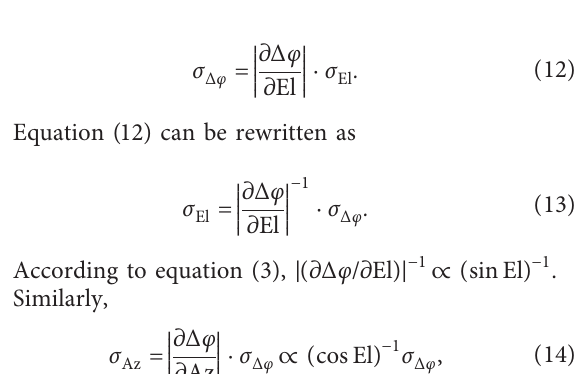
Figure 7: Received signal in (a) time domain and (b) frequency